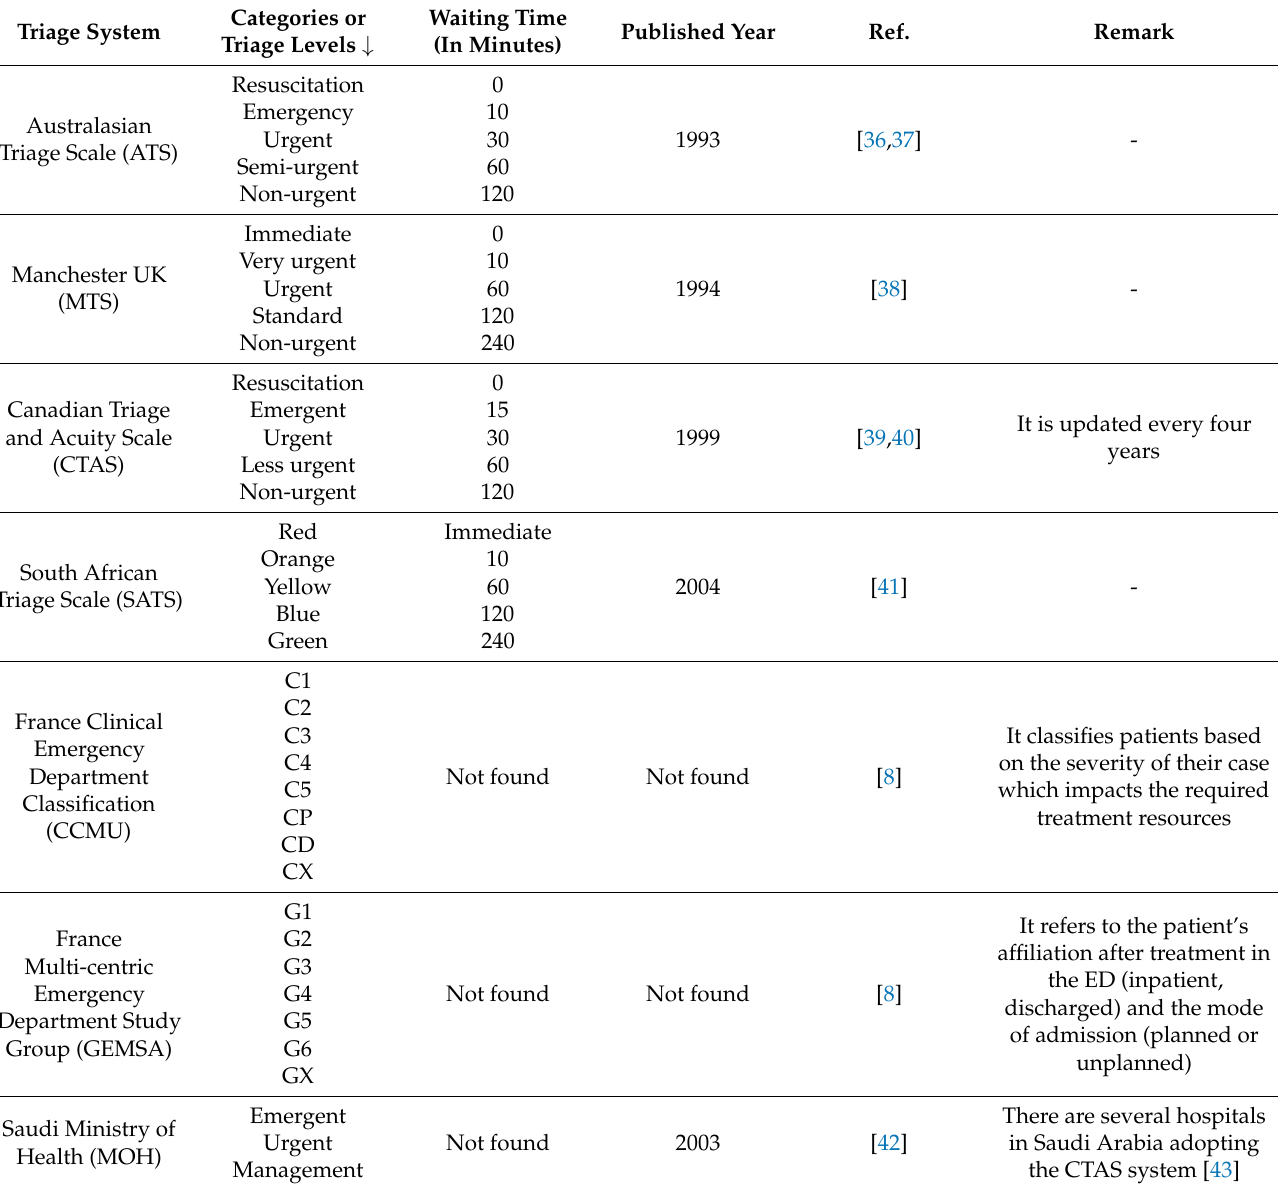
Table 1. Common international ED triage